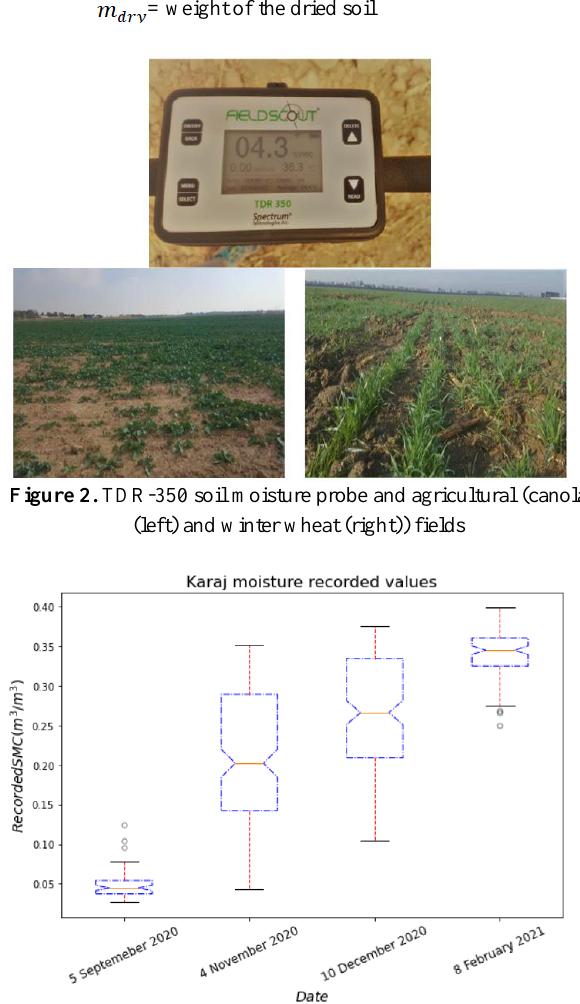
Figure 3. Ranges of the soil moisture content collected during In-situ measurement